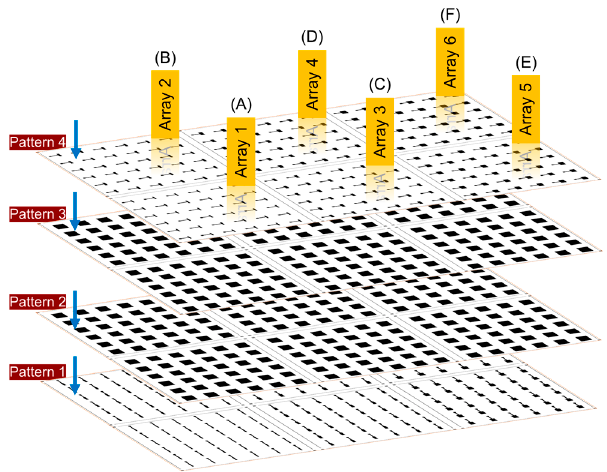
Figure 2. Digital pattern of the Ag bottom electrode layer for the different areas: ( A ) 5 mm 2 , ( B ) 7.5 mm 2 , ( C ) 10 mm 2 , ( D ) 12.5 mm 2 , ( E ) 17.5 mm 2 , ( F ) 20 mm 2 .